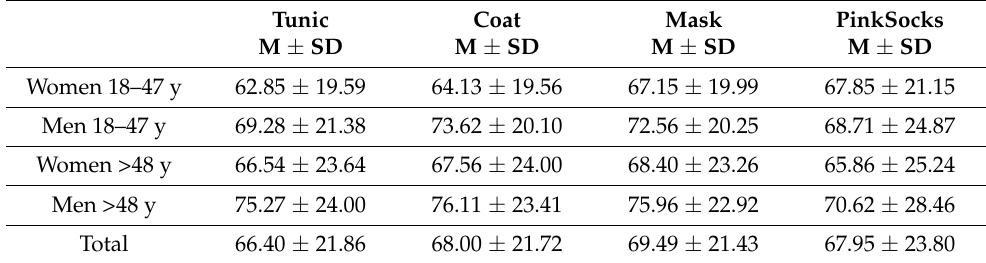
Table 3. Evaluation of the four photos according to trust (mean, standard deviation).